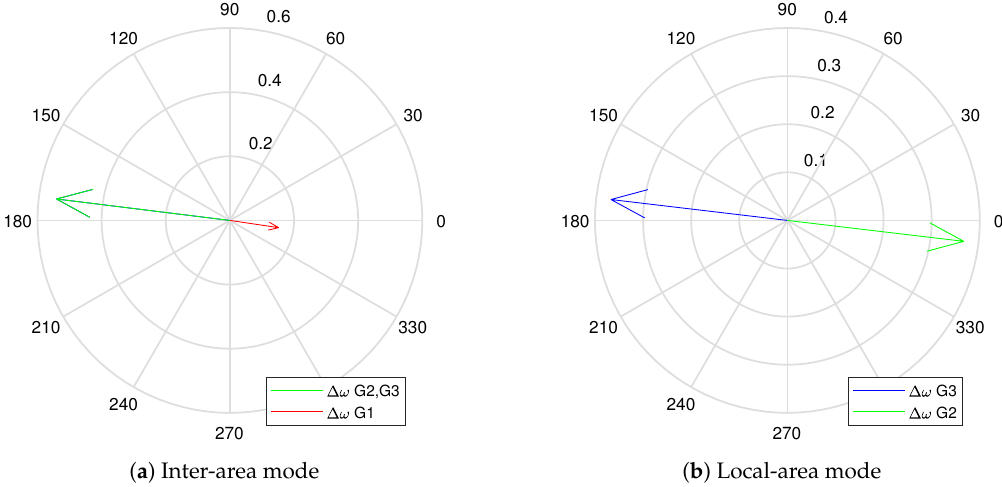
Figure 4. ( a ) Inter-area mode showing the swing of generator 1 with generators 2 and 3. ( b ) Local area mode showing the swing of generator 2 with generator 3.